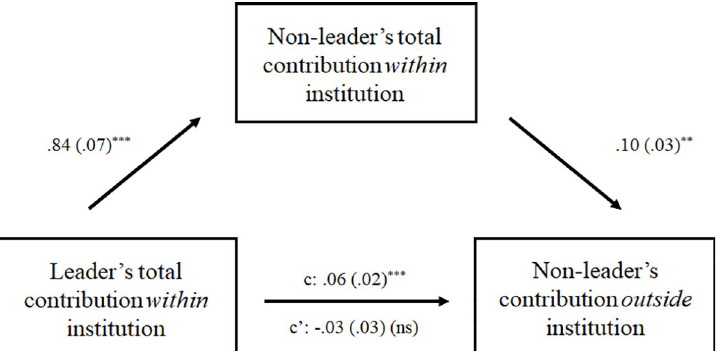
Fig 4. Mediation analyses, relationship between leader cooperative behavior within the institution and non-leader cooperation outside of the institution. Note: + p < .10, � p < .05, �� p < .01, ��� p < .001. Mediation analyses consisting of multilevel linear regression models (maximum likelihood estimation) with random intercepts for the group. Models also contained control terms for prosocial and antisocial punishments received within the institution. N = 84 participants nested in 28 groups. See also Table F in S1